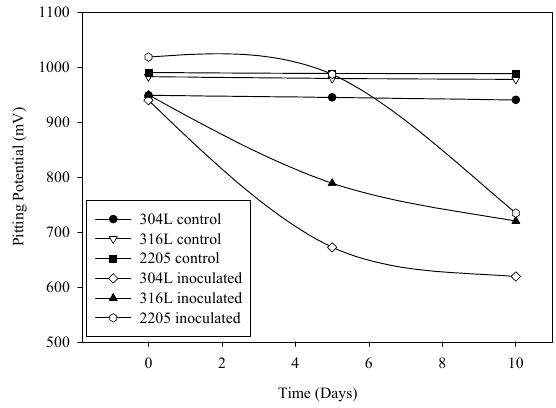
Figure 9. Relation between corrosion rate and EPS components in case of stainless steel 304L exposed to inoculated Baar’s media in immersion tests (with replenishment of media).